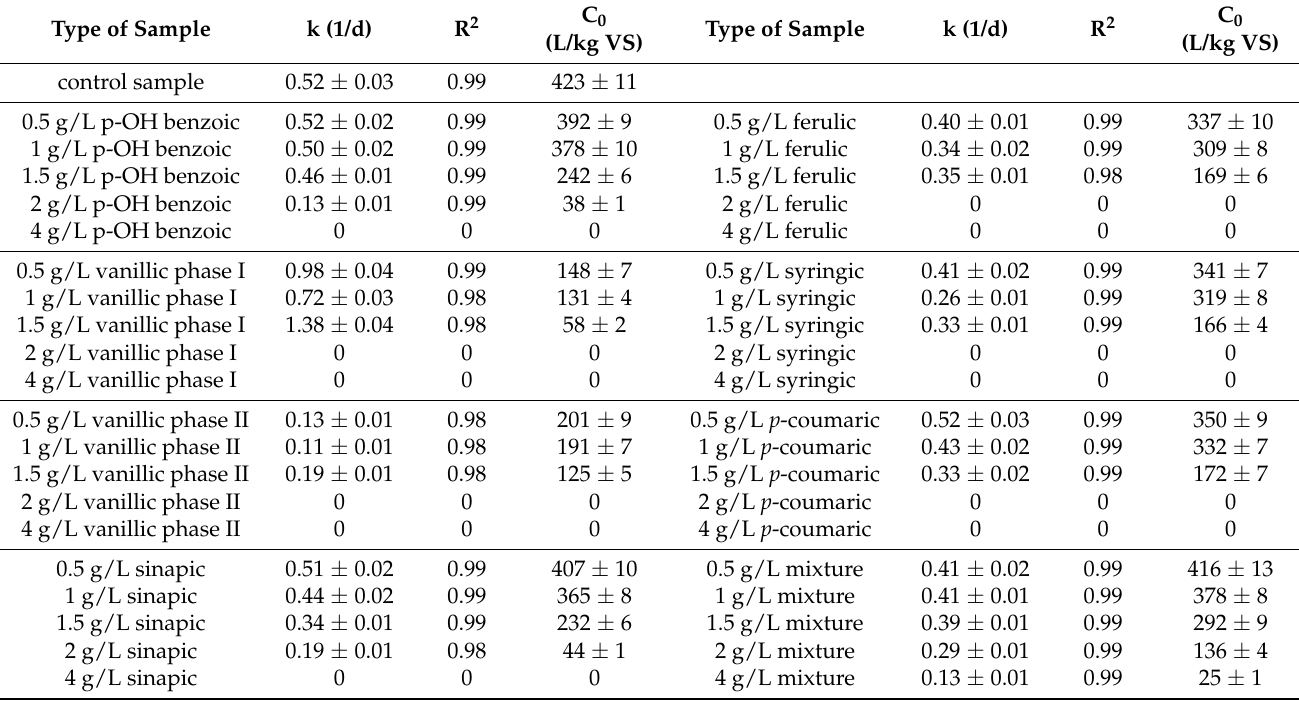
Table 3. Parameters of methane production using first-order